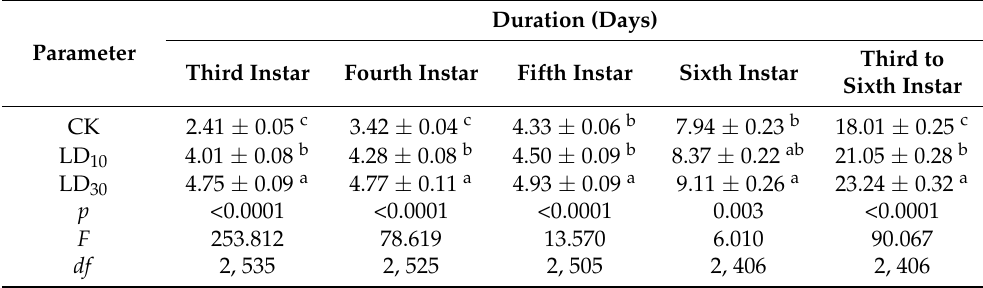
Table 2. Sublethal effect of fluxametamide on F 0 larvae duration of C. suppressalis.